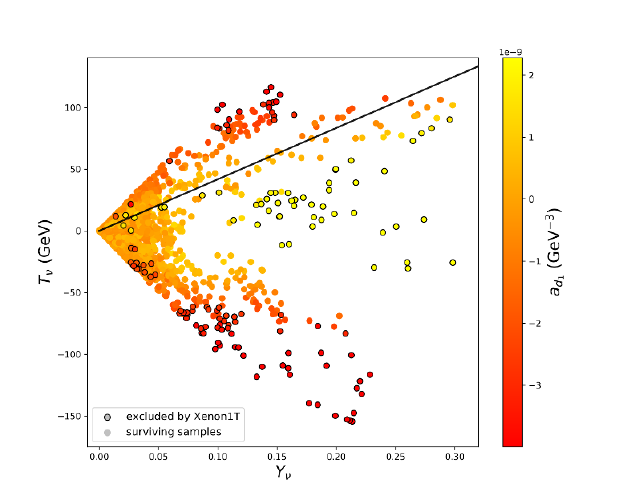
Figure 5 . Similar to (cid:12)gure 4, but projected on T (cid:23) (cid:0) Y (cid:23) plane with T (cid:23) (cid:17) Y (cid:23) A (cid:23) . The circled samples are excluded by the XENON-1T experiment, and the colors represent di(cid:11)erent values of a d are de(cid:12)ned by the colored bar on the right side of the (cid:12)gure.